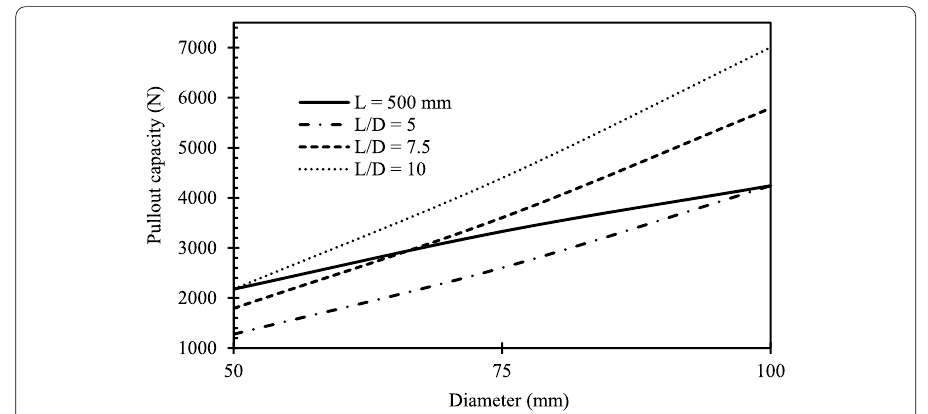
Fig. 13 Variation in pullout capacity with